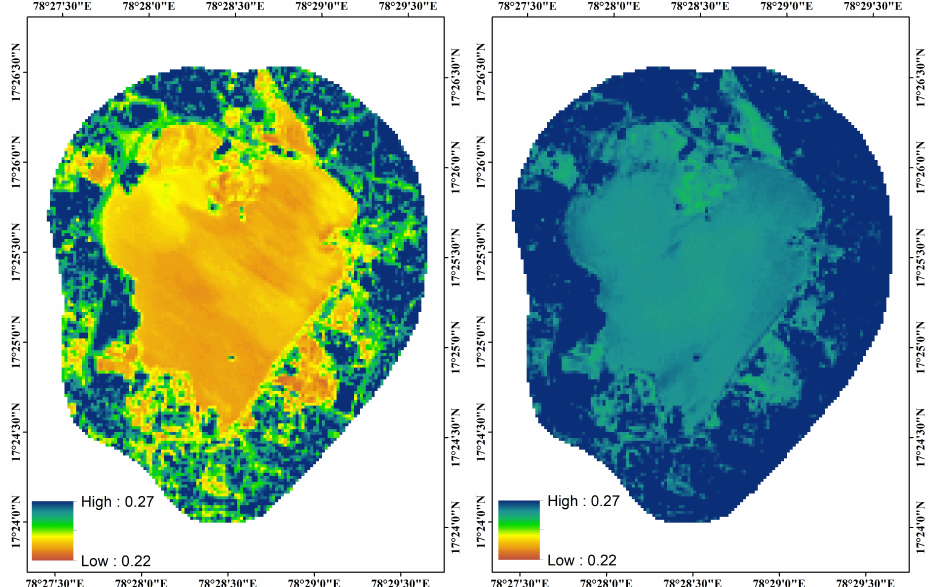
Figure 3. False color images showing changes in Band 2 spectral reflectance values for Lake HS: ( Left panel ) 15 March 2020 (Before the COVID-19 lockdown); ( Right panel ) 16 April 2020 (During COVID-19 lockdown). Blue color shows the maximum reflectance, and orange color shows the minimum reflectance. (Legend shows the color band for the entire reflectance